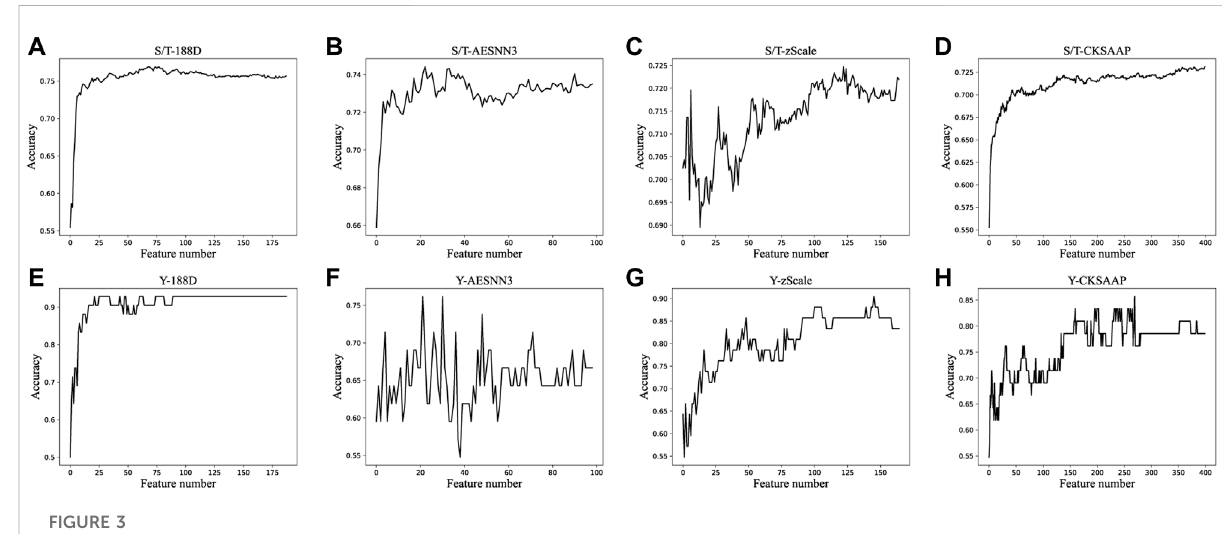
FIGURE 3 Accuracies derived from the incremental strategy using different feature extraction methods.